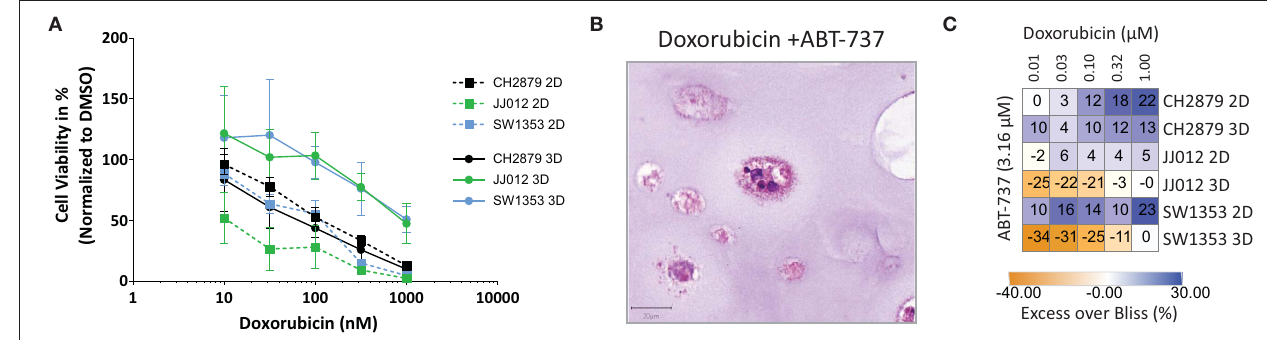
FIGURE 5 | Evaluation of synergy. (A) Combination treatment with doxorubicin and ABT-737 was shown to be more effective in 2D than 3D cultures ( n = 3). (B) The number and size of colonies was reduced after treatment. Scale bar = 20 µ m, cell line = CH2879. (C) Synergy heatmap indicating Excess over Bliss values for chondrosarcoma in vitro combination therapy shows that spheroids lack the synergy that is seen using monolayer cells. Synergistic > 0, additive = 0, antagonistic < 0. Results were normalized to DMSO